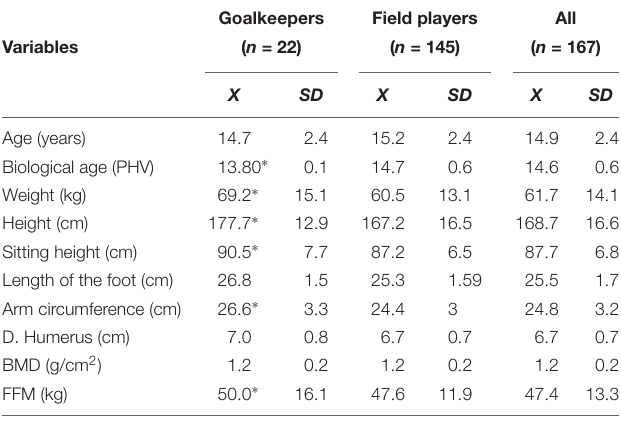
TABLE 1 | Variables that characterize the studied sample in goalkeepers and field